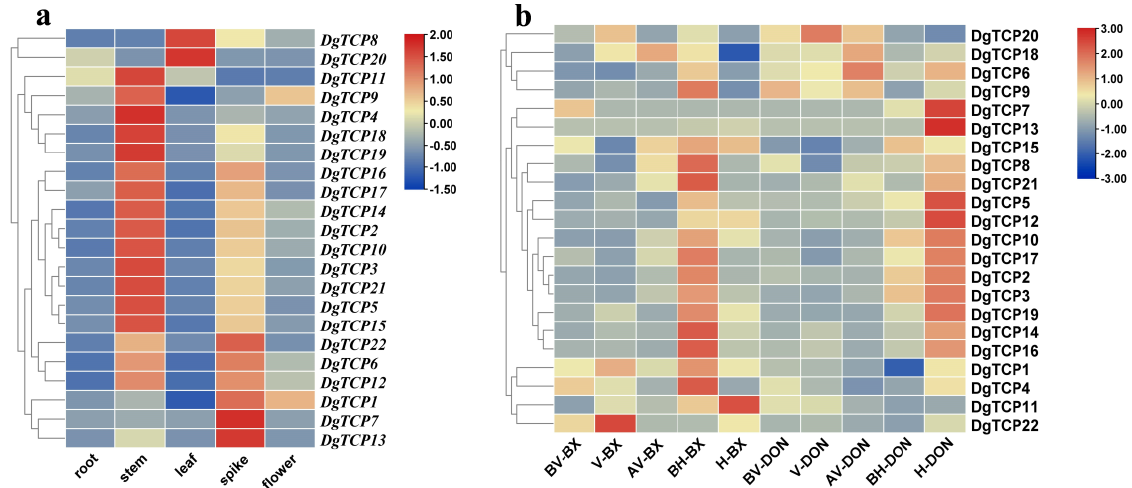
Figure 8. Expression profiles of 22 DgTCP genes in different orchardgrass tissues and developmen- tal stages. ( a ) The 22 DgTCPs in different tissues. ( b ) The 22 DgTCPs in “Baoxing” and “Donata” at 5 developmental stages. Color changes from blue to red represent relatively low or high expression, respectively.